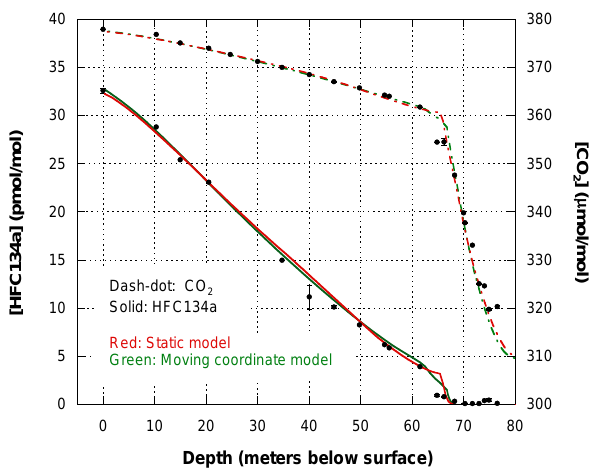
Fig. 3. Output of two different versions of the firn model: the static formulation and the moving-coordinate formulation. Each model was run with its own diffusivity-depth profile. Two species with very different atmospheric histories (Montzka et al., 1996; Etheridge et al., 1996; Conway et al., 2010) were chosen for illus- trative purposes. Also shown are our measurements of the firn air, with error bars. The error bars are based on the pair-wise agreement of replicate flasks collected at each depth, and are usually smaller than the markers on the